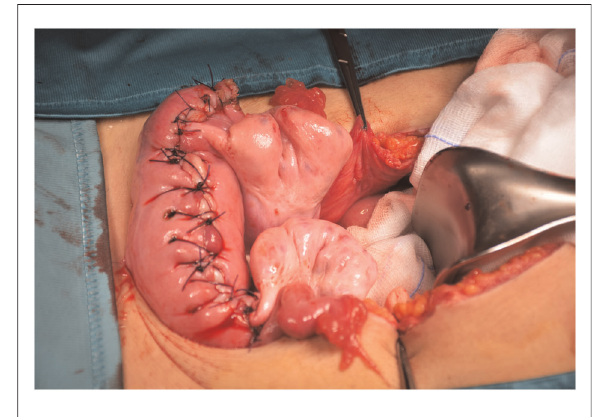
FIGURE 1 Intraoperative image showing the proximity of the lesion to the fallopian tubes and ovaries.